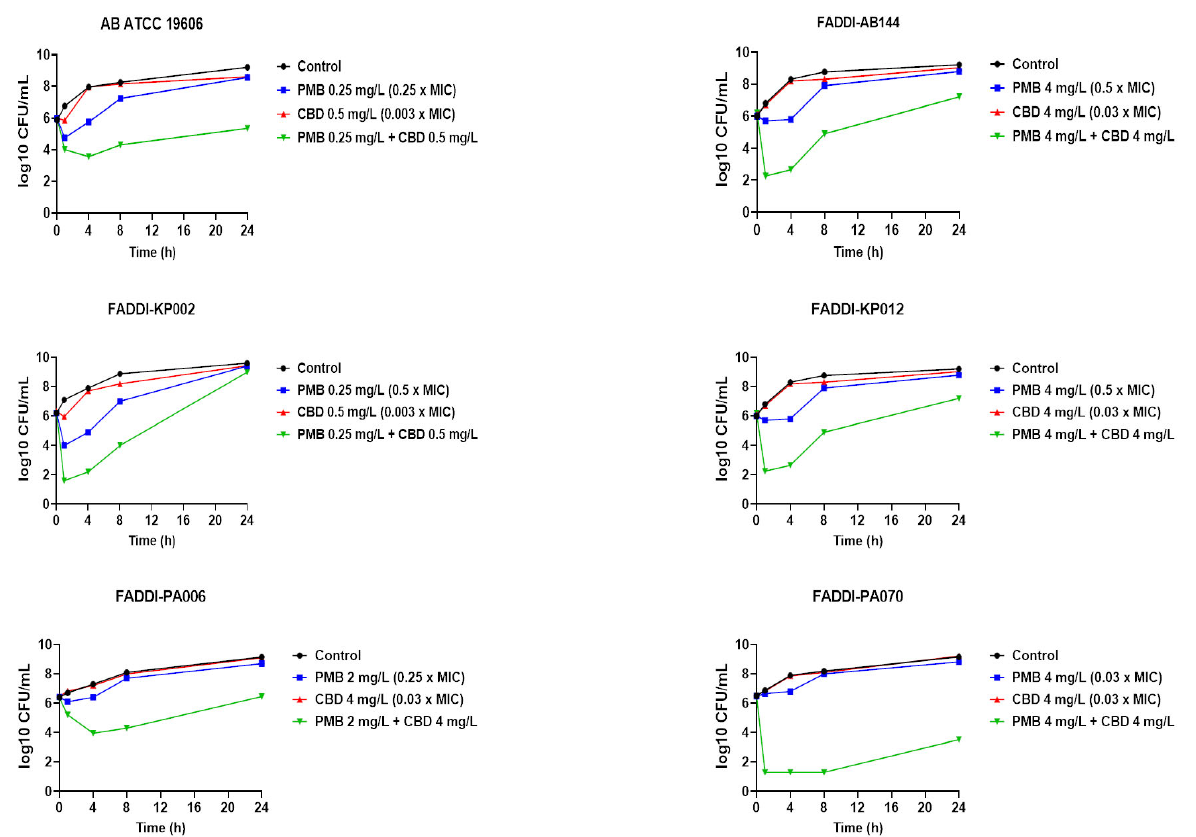
Figure 1. Time ‐ kill curves for polymyxin B (PMB) and cannabidiol (CBD) monotherapies and in combinations against polymyxin B ‐ susceptible A. baumannii strain ATCC 19606 (polymyxin B MIC = 1 mg/L, cannabidiol MIC > 64 mg/L) and polymyxin B ‐ resistant A. baumannii strain FADDI ‐ AB144 (polymyxin B MIC = 8 mg/L, cannabidiol MIC > 64 mg/L); against polymyxin B ‐ susceptible K. pneumoniae FADDI ‐ KP002 (polymyxin B MIC = 0.5 mg/L, cannabidiol MIC > 64 mg/L) and polymyxin B ‐ resistant K. pneumoniae FADDI ‐ KP012 (polymyxin B MIC = 32 mg/L, cannabidiol MIC > 64 mg/L); against polymyxin B ‐ resistant P. aeruginosa strains FADDI ‐ PA070 (polymyxin B MIC = 128 mg/L, cannabidiol MIC > 64 mg/L) and FADDI ‐ PA006 (polymyxin B MIC = 8 mg/L, cannabidiol MIC > 64 mg/L). Data are mean values of three independent cultures, and vertical bars represent the standard deviations. Error bars are too small to appear in the graphs.